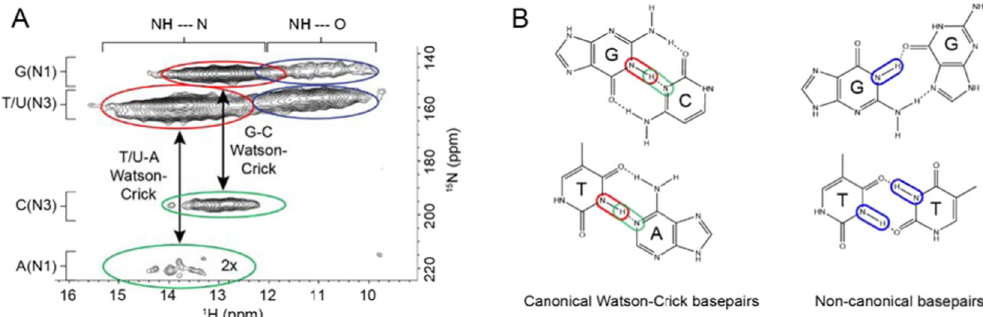
Fig. 3 Solid-state NMR reveals the presence of non-canonical base pairs or tetrads in eDNA. A Representative solid-state 2D 1 H – 15 N through-space heteronuclear correlation (HETCOR) spectrum of extracellular nucleic acid (NA) gel isolate in double-distilled water (2 mg), T = 25 °C. Red ovals show the cross-peaks from direct N – H couplings of G (N1 – H1) and T/U (N3 – H3) when the protons are hydrogen-bonded to nucleobase nitrogen atoms (i.e. NH ··· N). Green ovals indicate the cross-peaks generated from indirect (via hydrogen bonds) N – H couplings between G(H1) and C(N3) as well as between T/U(H3) and A(N1). The threshold for the A(N1) – T/U(H3) correlation is increased due to lower signal intensity for that particular coupling. Cross-peaks denoted by red and green ovals indicate Watson – Crick G – C and U/T – A base pairings, respectively. Blue ovals show cross-peaks from direct N – H couplings of G (N1 – H1) and T/U (N3 – H3) when the protons are hydrogen-bonded to carbonyl oxygen (i.e. NH ··· O). These cross-peaks reveal non-canonical base pairings between G, T or U and G, T, U or C as well as the possibility of G-tetrad formations. B Canonical and non-canonical base pairing schematics illustrate the possible correlations observed in the HETCOR spectrum. The correlations are colour-coded to match the spectrum. Covalent and hydrogen bonds are indicated by solid and dashed lines,